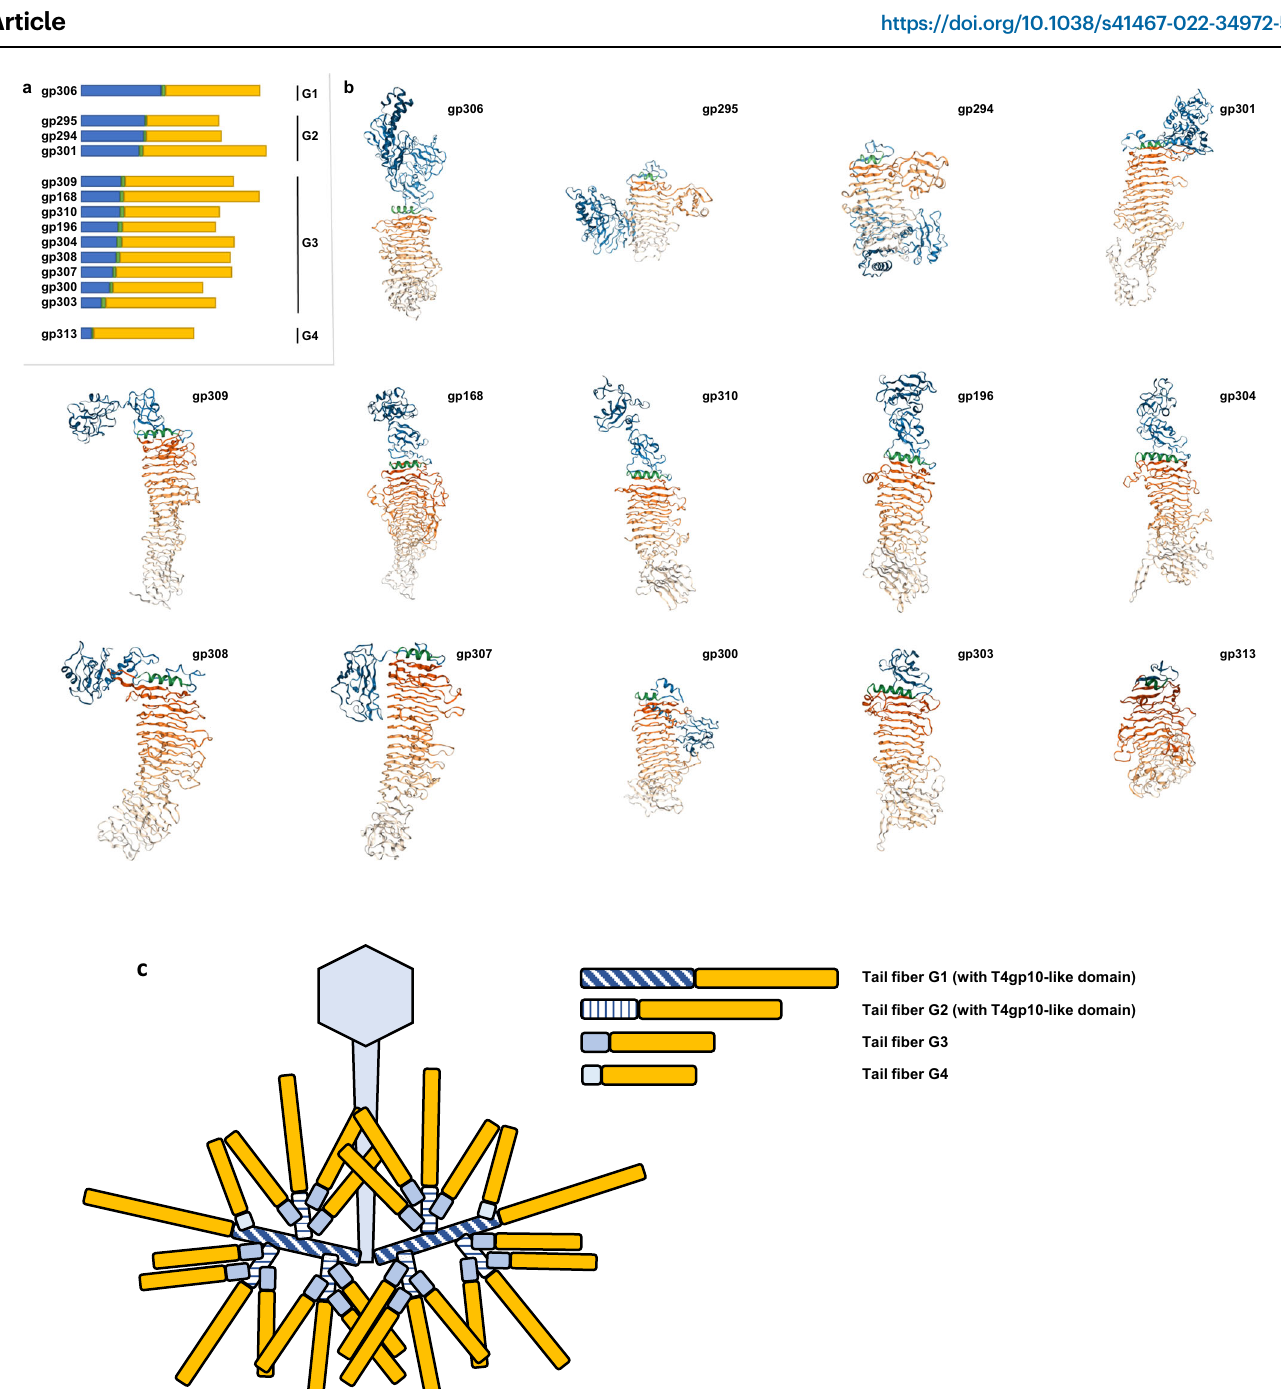
structures. Tail fi bers with depolymerase activity are typically composed of struc- turalmodulesresponsiblefortailattachmentand branching(blue),aseparating α - helix (green), and a β -helix with enzymatic activity (yellow). c A hyperbranching model of tail fi bers of ϕ